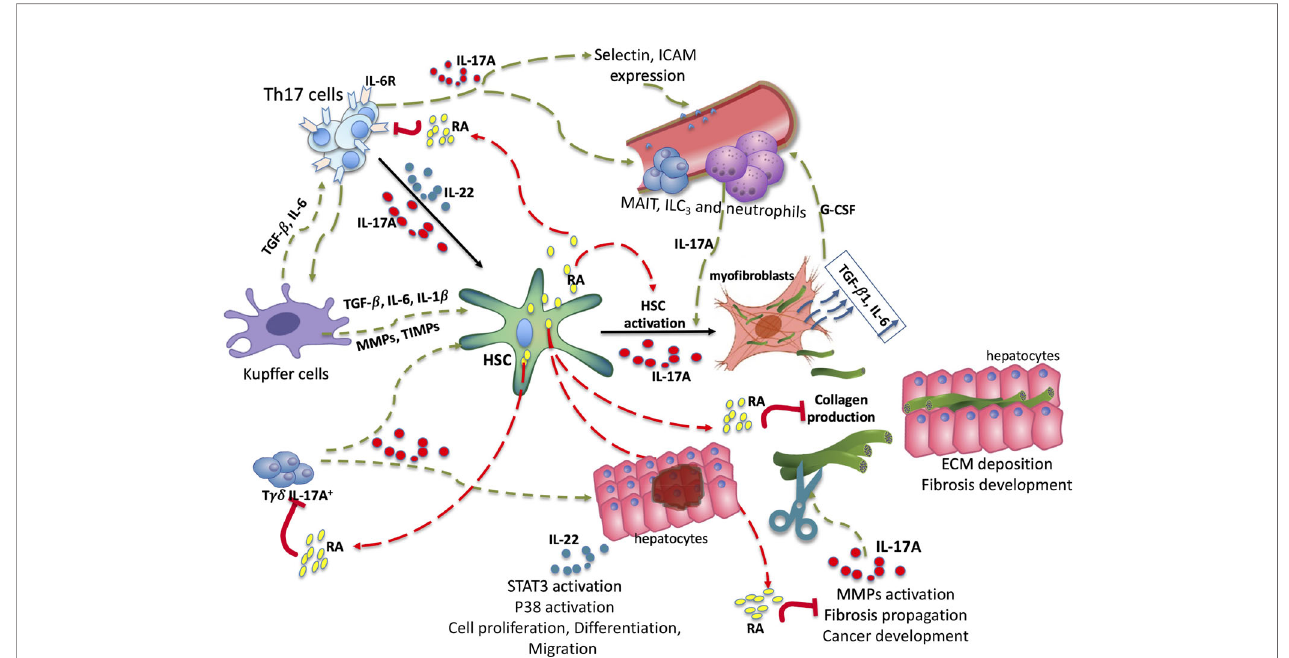
FIGURE 3 | Trio IL-17A/RA/IL-22 in development of liver fi brosis. Under the in fl uence of damaging factors there is an activation of the intrahepatic immune system guided by IL-17A, TGF- b 1 and IL-6. Under TGF- b 1 and IL6 secreted by Kupffer cells, as well as IL-17A secreted by T gd , Th17, myeloid populations, there is an activation of HSC. Upon activation, the HSC releases lipid droplets fi lled with retinyl esters and transforms into myo fi broblasts, generating the extracellular matrix, notably collagen. IL-17A promotes the migration of circulating immune cells. RA is able to disrupt IL-17A, TGF- b 1 and IL-6 signaling by inhibiting the expression of IL-6 receptors, thereby moderating HSCs activation. Fibrosis progression is associated with permanent remodeling of the deposited matrix. RA is capable of inhibiting MMP-2, MMP-9, certain TIMPs, and thus moderating the spread of fi brosis. Through STAT3 activation IL-22 contributes to hepatocyte proliferation, differentiation and migration. HSC, hepatic stellate cell; RA, retinoic acid; ECM, extracellular matrix; MMP, metalloproteinase; TIMP, tissue inhibitor of metalloproteinase; ILC3s, type 3 innate lymphoid cells; MAITs, mucosal associated invariant T cells. Red arrows — possible inhibitory effect, Green arrows — possible activator